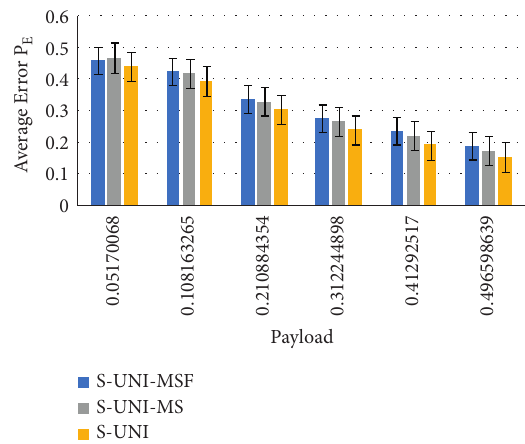
Figure 8: Performance comparison of image enhancement algo- rithms on feature set SRM.